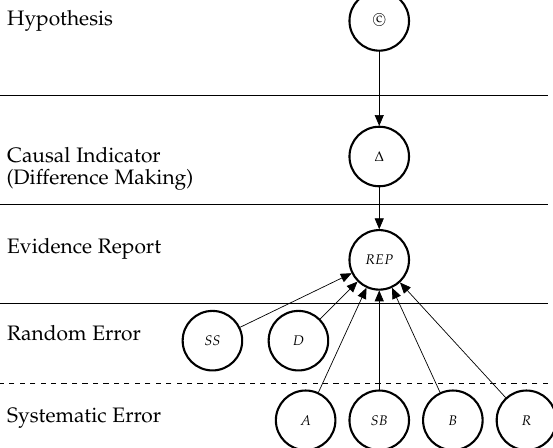
Figure 2. Graph structure of the Bayesian network for one randomised controlled trial (RCT) which informs us about difference making ( ∆ ) which in turn informs us about the causal hypothesis. The information provided by the reported study is modulated by how well the particular RCT guards against random and systematic